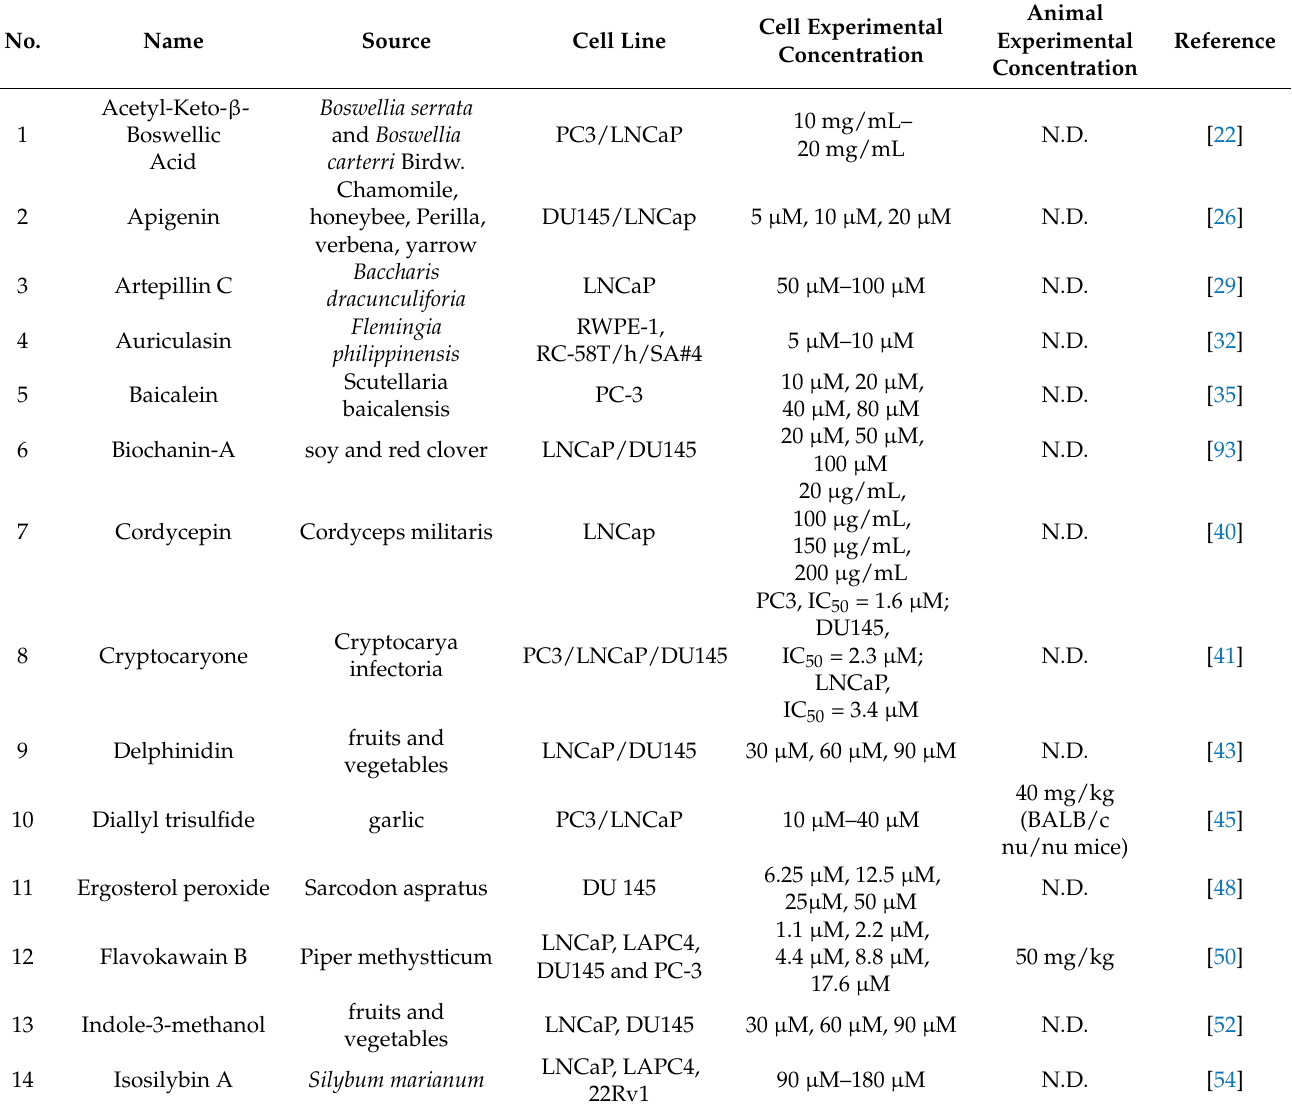
Table 2. Natural compounds that suppress prostate cancer by promoting expression of death receptor